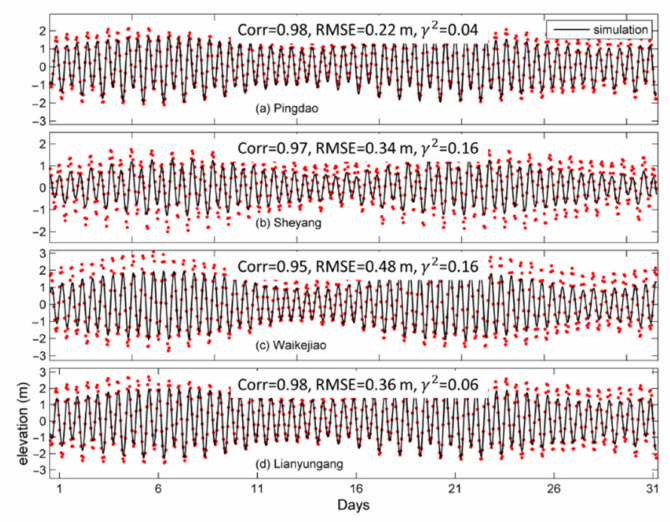
Figure 4. Time series of observed and simulated surface elevations at four coastal tidal gauge stations ( a ) Pingdao, ( b ) Sheyang, ( c ) Waikejiao and ( d ) Lianyungang in July